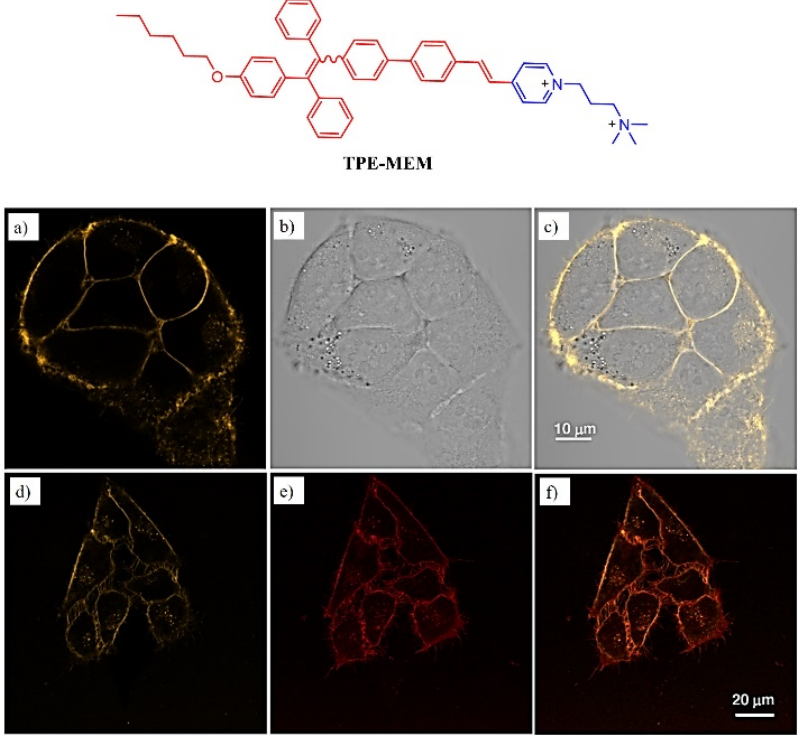
Figure 17. The structure of the fluorescent marker probe (TPE-MEM) imaged under confocal mi- croscopy was captured for TPE-MEM upon incubation of HeLa cells. ( a ) Images under laser scanning confocal microscopy, ( b ) images under bright field, and ( c ) merged images for HeLa cells stained with the TPE-MEM. Image of HeLa cells co-stained with ( d ) TPE-MEM and ( e ) the CellMask Deep Red plasma membrane and followed by image. Further, ( f ) shows merged fluorescence images of ‘a & b’. Reprinted from reference [93] with the permission of American Chemical Society.